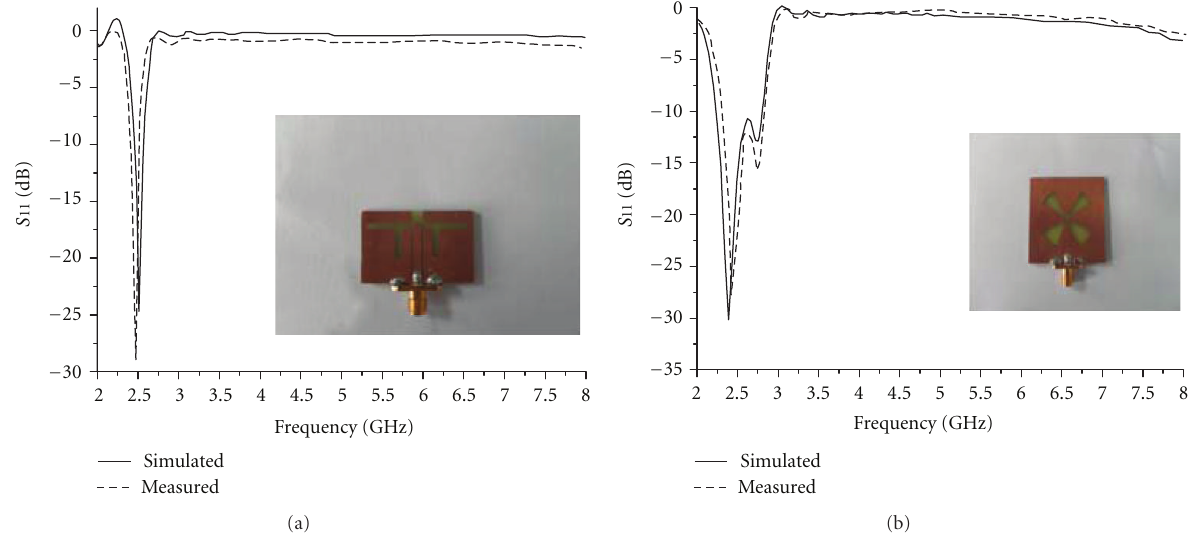
Figure 8: The simulated and measured return losses for (a) antenna 2 and (b) antenna